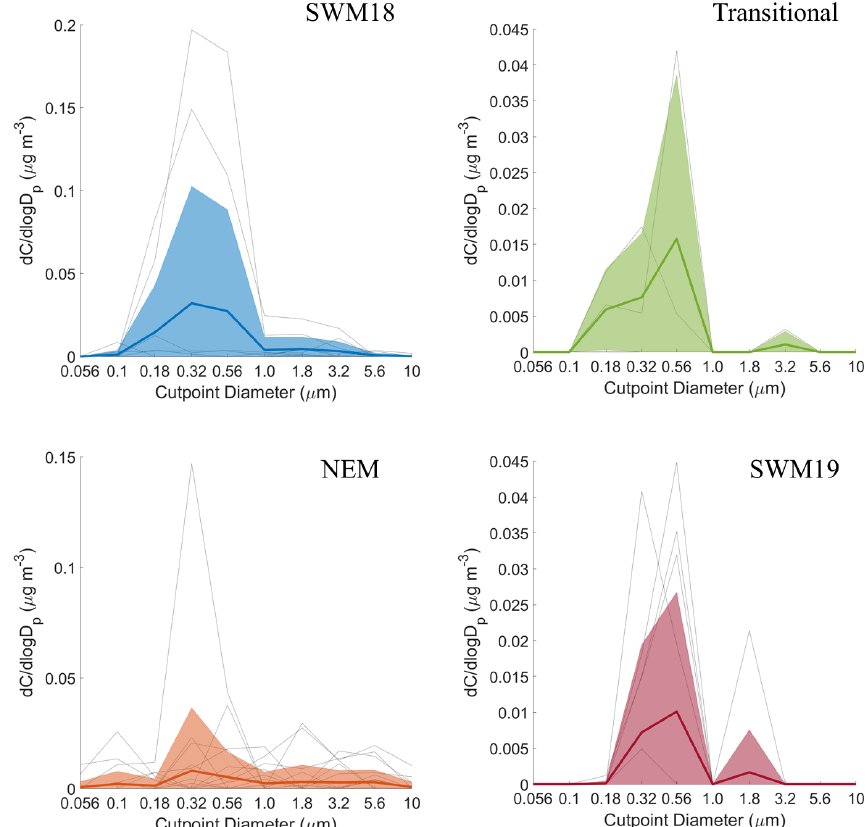
Figure 8. Same as Fig. 6 but for